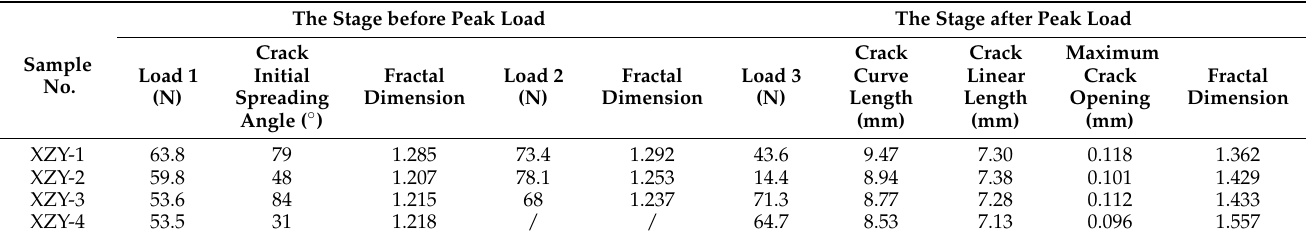
Figure 7. Micro-crack morphology on XZY-3 sample under different loads. ( a ) The load-displacement curve; ( b ) Before load; ( c ) Micro crack is spotted; ( d ) Micro crack propagation; ( e ) The width of main crack formed. Table 5. The size parameters and fractal dimensions of main cracks during